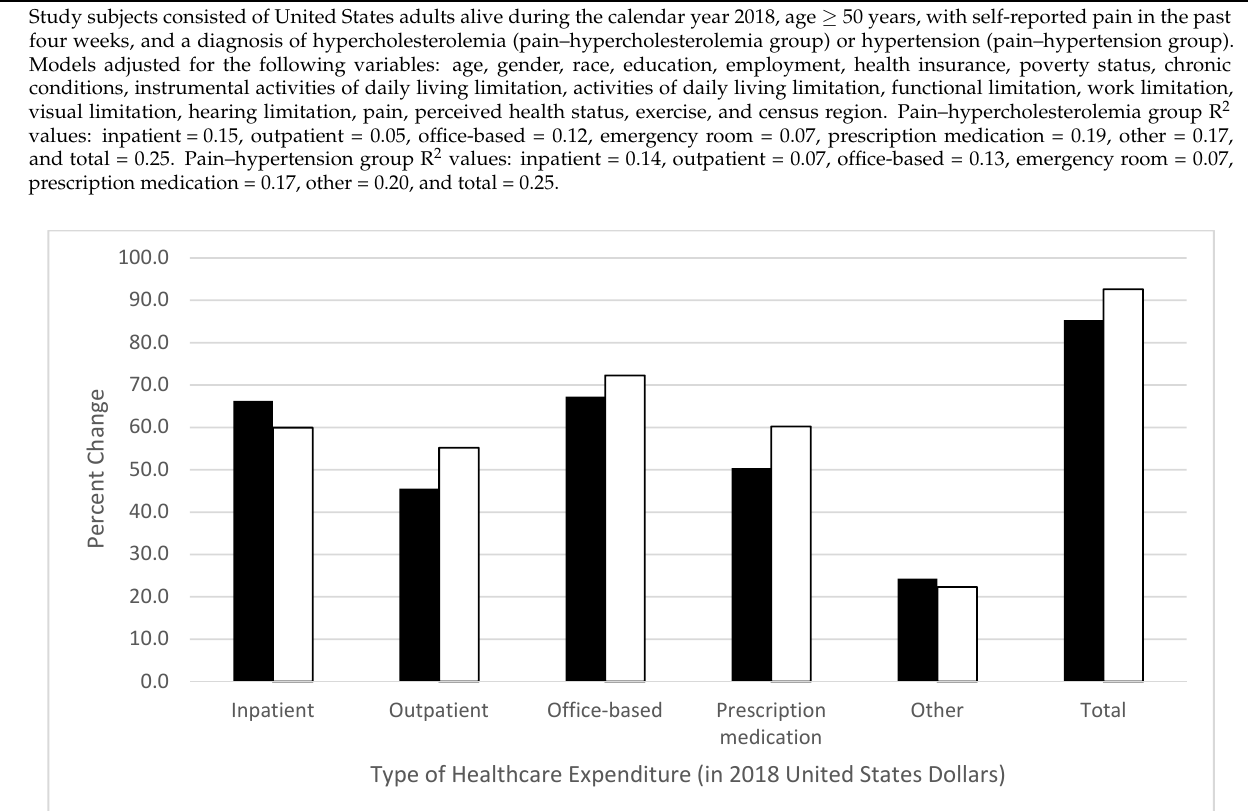
Figure 1. Percent difference in 2018 healthcare expenditures for opioid users versus non-users among United States adults age ≥ 50 years with pain in the past four weeks and a diagnosis of hypercholesterolemia or hypertension, after adjusting for predisposing, enabling, need, personal, and environmental factors. Percent change represents the difference in expenditure between opioid users and non-users, calculated by using semi-logarithmic equations (e β − 1). Black bars represent the pain–hypercholesterolemia group. White bars represent the pain–hypertension group. The p -values for pain–hypercholesterolemia group: inpatient p = 0.0033, outpatient p < 0.0011, office-based p < 0.0001, prescription medication p < 0.0001, other p = 0.0056, total p < 0.0001, and emergency room p = 0.7068. The p -values for pain–hypertension group: inpatient p = 0.0043, outpatient p = 0.0006, office-based p < 0.0001, prescription medication p < 0.0001, other p = 0.0084, total p < 0.0001, and emergency room p = 0.1706.